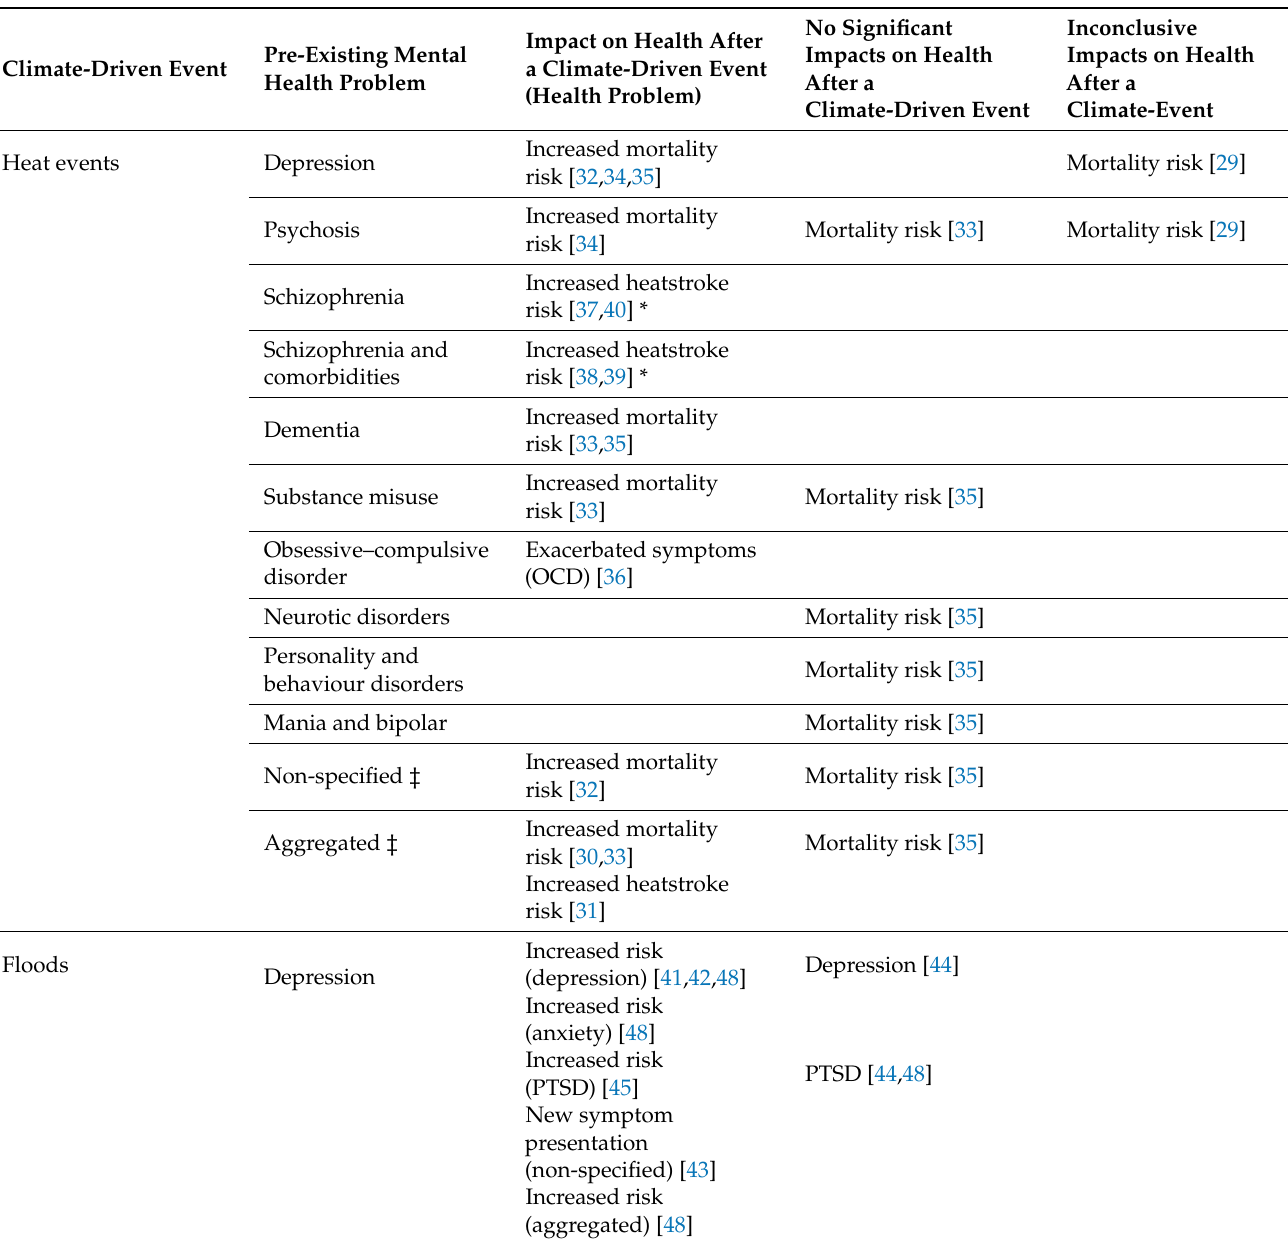
Table 1. Summary of the health impacts after a climate-driven event among people with pre-existing mental health problems. Results from case studies are indicated with an asterisk (*). References are given in